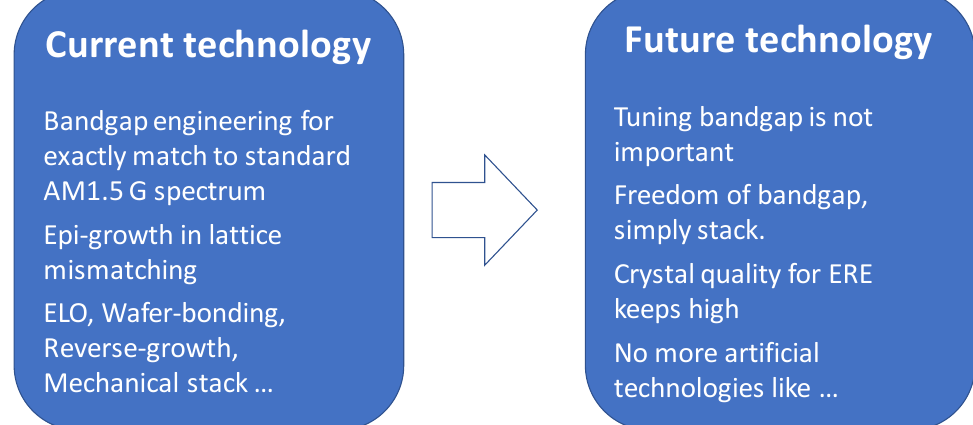
Figure 14. Possibility of the future high-e ffi ciency solar cell technology based on the implication from the super-multi-junction solar cell.